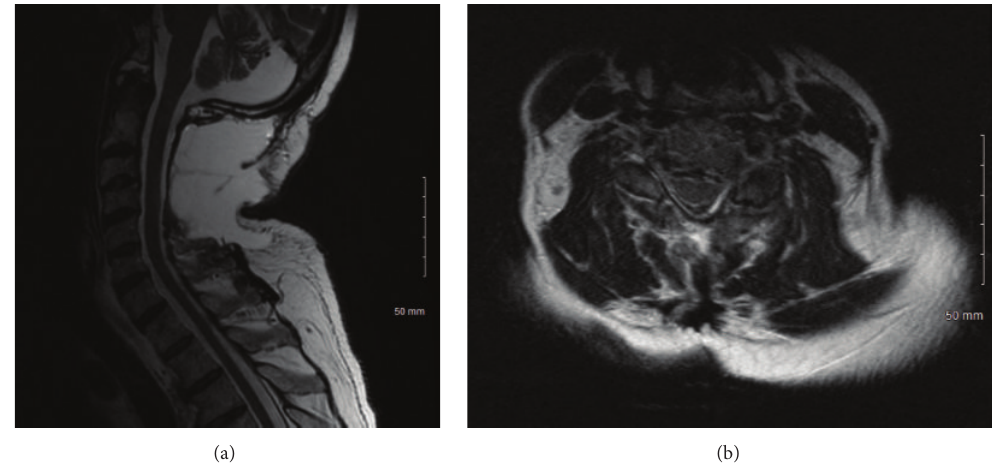
Figure 5: Postoperative T2-sequence MRI of the cervical spine. Sagittal (a) and axial (b) images, showing complete resolution of the preoperative intramedullary lesion and its surrounding T2-signal